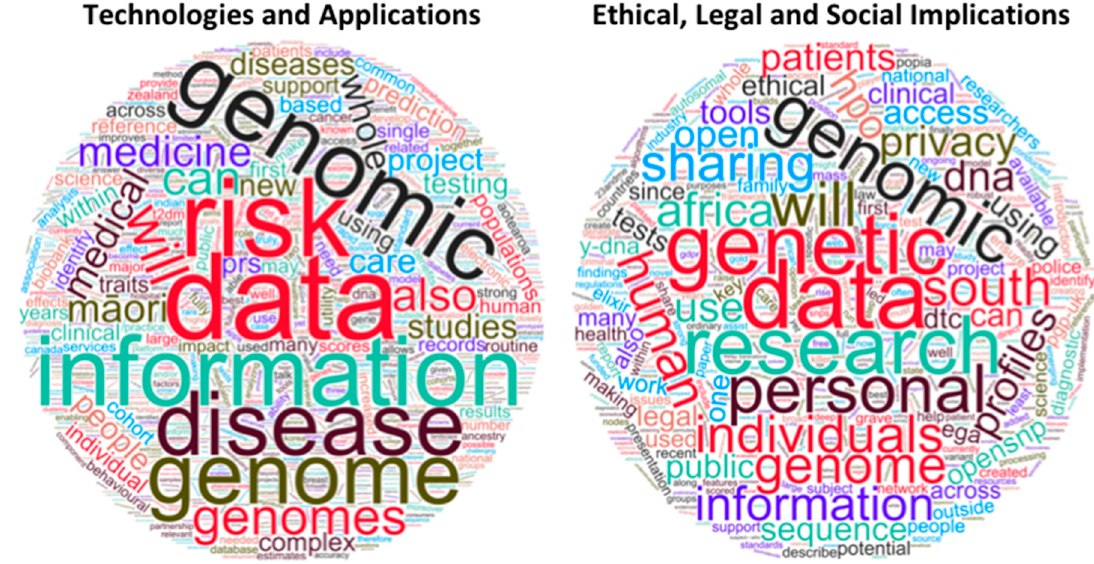
Figure 1. Word clouds from the titles and abstracts of the two Topic Areas: Technologies and Applications ( left ) and Ethical, Legal and Social Implications ( right ). Font size reflects word frequency; colors and word directions are arbitrary. Generated using WordClouds.com.